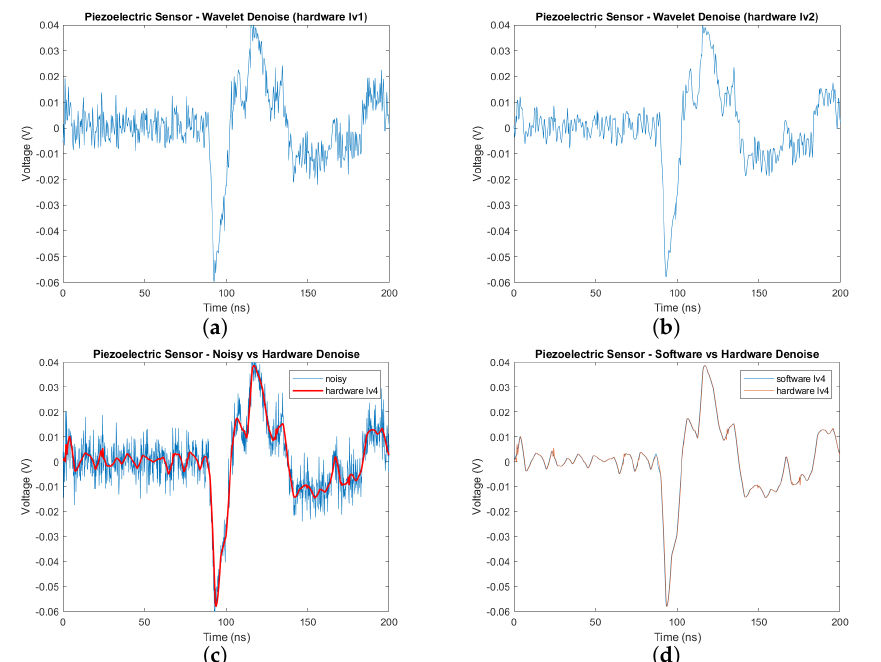
Figure 14. Wavelet Denoise with various levels using hardware implementation: ( a ) Wavelet denoise level 1—hardware version. ( b ) Wavelet denoise level 2—hardware version. ( c ) Wavelet denoise level 4